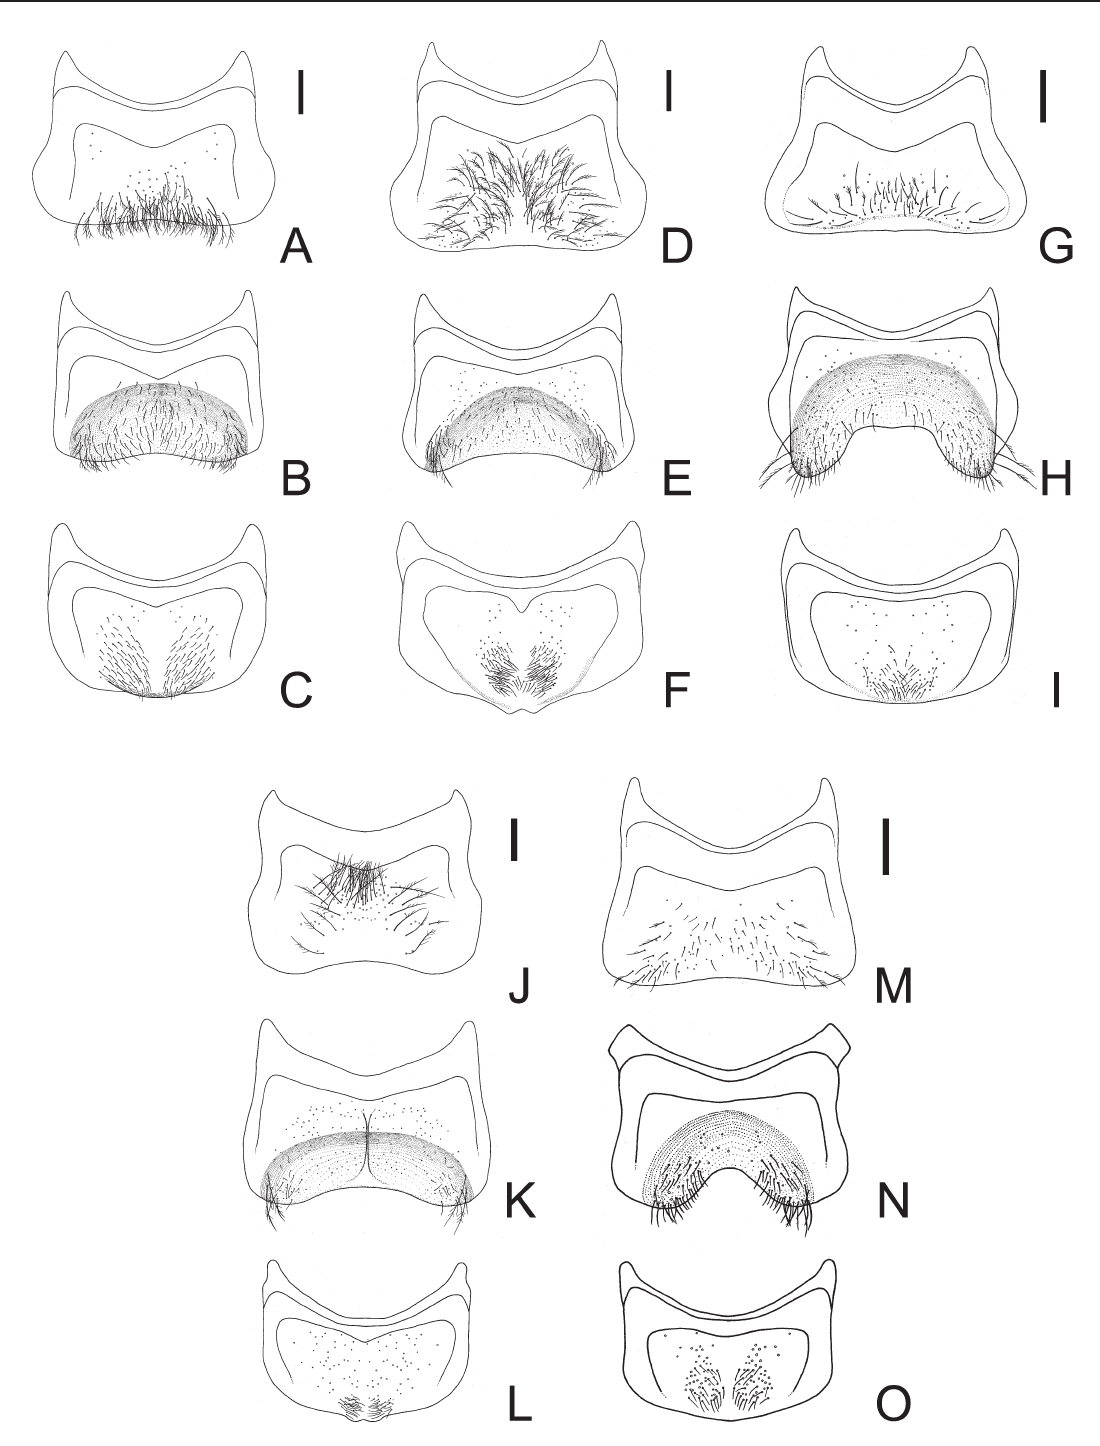
Fig. 5. S4–S6 in species of the atroglaucum subgroup, ♂. — A–C . Lasioglossum ( Dialictus ) atroglaucum (Strand, 1913). — D–F . Lasioglossum ( Dialictus ) virideglaucum ebmer & Sakagami, 1994. — G–I . Lasioglossum ( Dialictus ) yamanei Murao et al ., 2006 — J–L . Lasioglossum ( Dialictus ) negoroi Murao & Tadauchi, 2008, paratype. — M–O . Lasioglossum ( Dialictus ) taiwanense Murao sp. nov., paratype. a, d, G, J, M: S4. B, e, h, K, N: S5. c, F, i, L, o: S6. dotted area on S5 shows the apical depression. Scale bars: 0.2